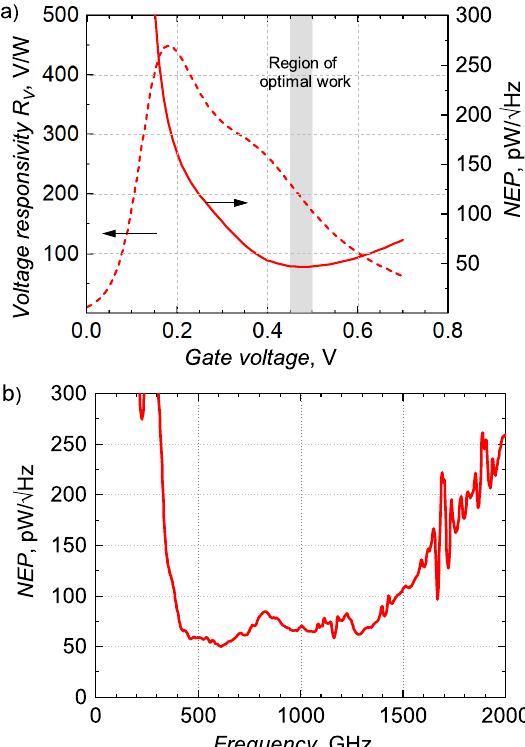
Figure 2. ( a ) The measured optical voltage responsivity (cid:60) V (dashed curve, left axis) and optical NEP (solid curve, right axis) of the detector at 609 GHz as a gate voltage function. The VDI source was used for measurements. ( b ) The measured optical NEP dependency on a frequency of the photomixer source used in the homodyne